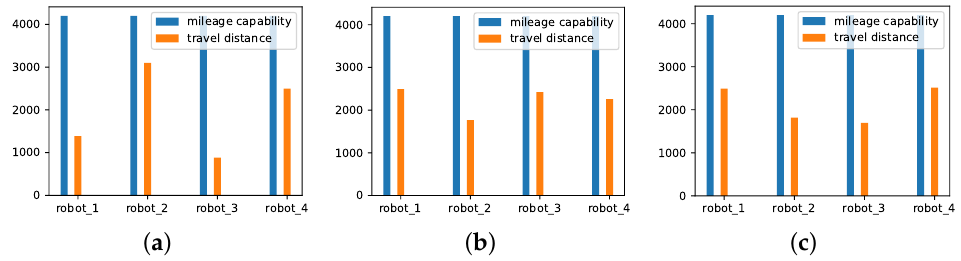
Figure 7. The travel distance of each robot, ( a – c ) correspond to the three solutions sampled from Figure 6a.